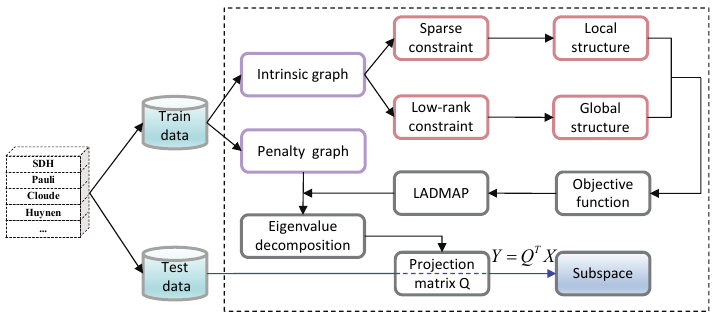
The flowchart of learning a low-dimensional sparse and low-rank subspace of high-dimensional PolSAR data based upon graph embedding. The features in the learned subspace are used for subsequent